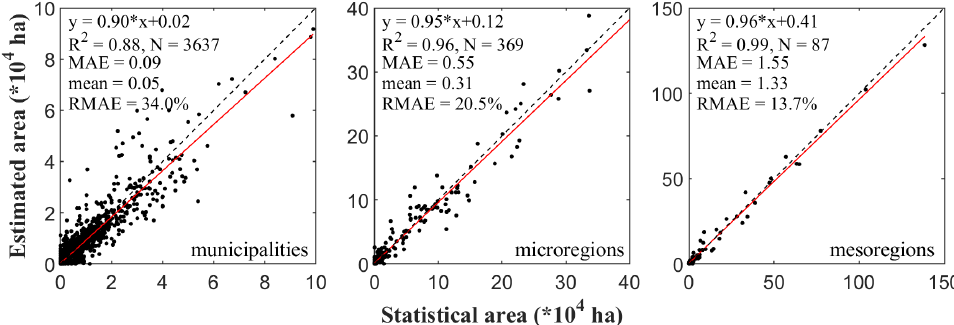
Figure 10. Comparisons between the agricultural statistical harvest area and the estimated harvest area of sugarcane at the municipality, microregion, and mesoregion levels in Brazil in 2018. “N” and “mean” represent the number and mean value of all the valid statistical data in each figure,